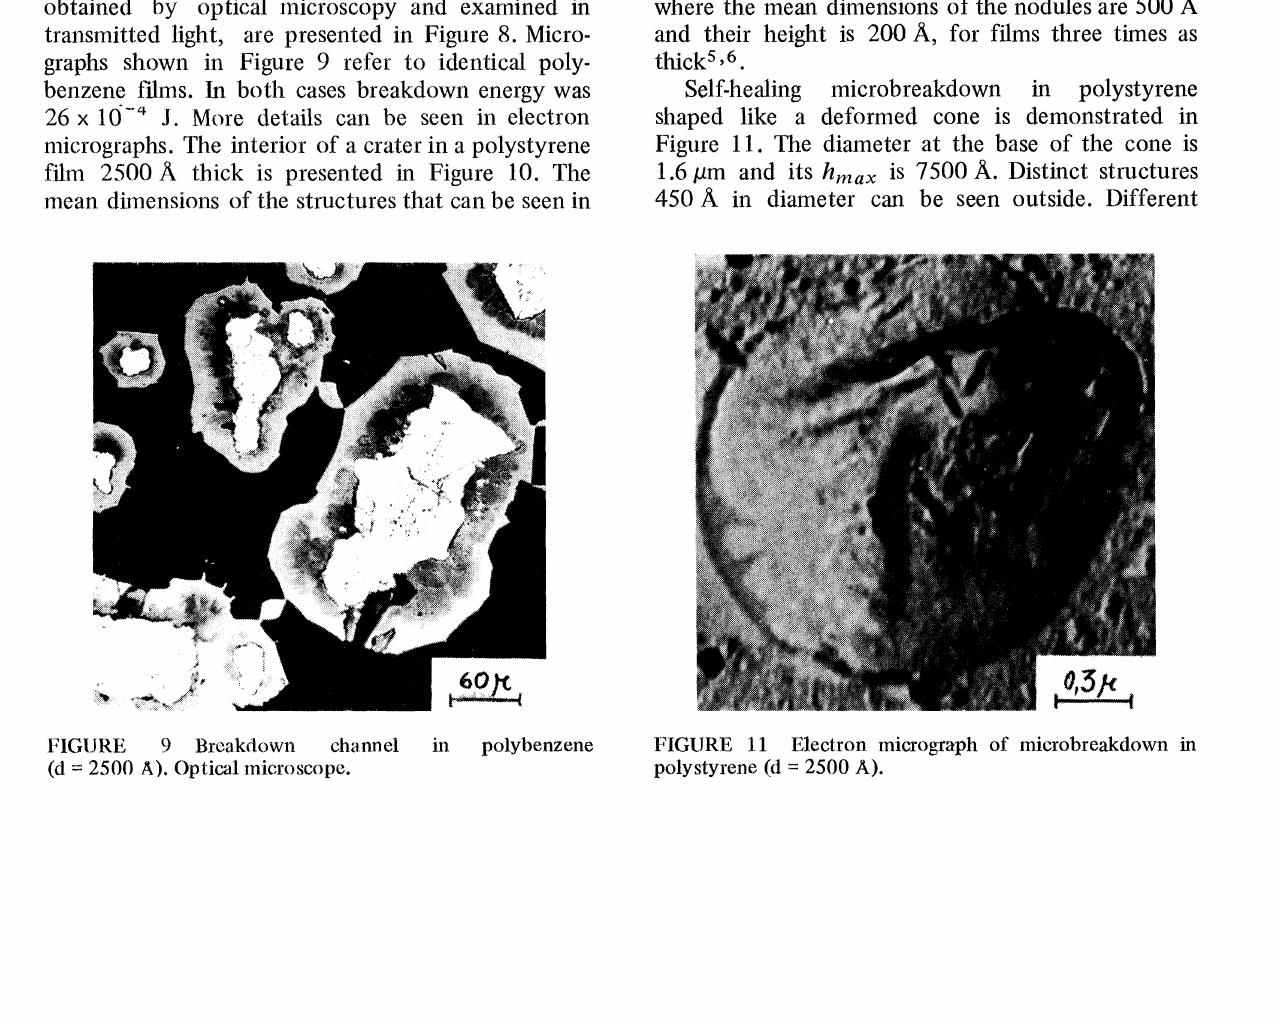
9 Breakdown channel in polybenzene FIGURE 11 Electron micograph of microbreakdown in polystyrene (d 2500 (d 2500 A), Optical microscope.